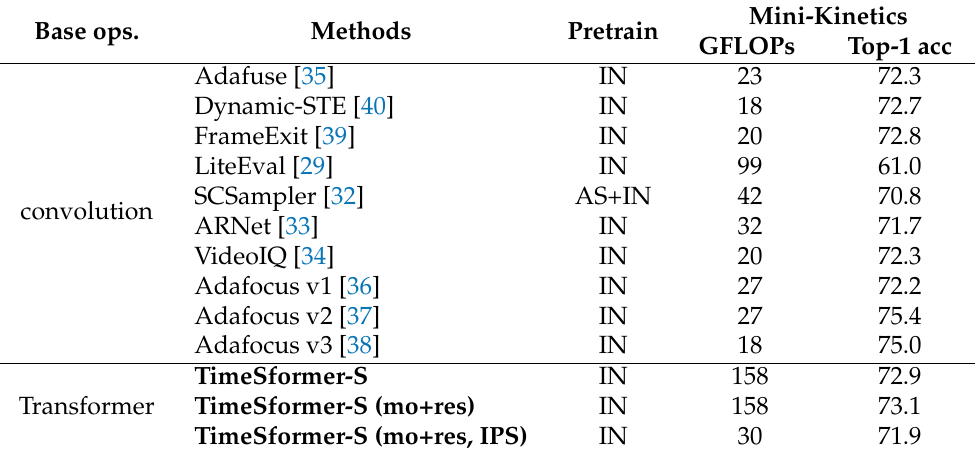
Table 6. Comparison with state-of-the-art methods on Mini-Kinetics. ”IN” and ”AS” represent ImageNet [53,54] and Audioset [56], respectively. Our methods appear in boldface. ”mo+res” stands for taking P-frames as motions and residuals. All of our methods take 24 frames with the frame size of 144 × 144 and